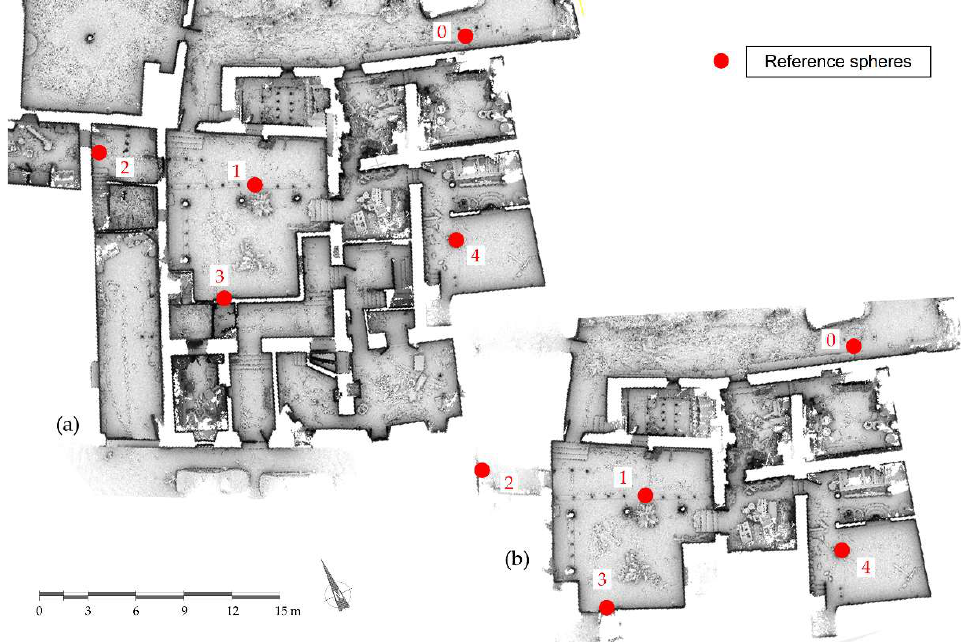
Figure 11. Reference sphere distribution on the ground floor for the path 3 ( a ) and path 4 ( b ).